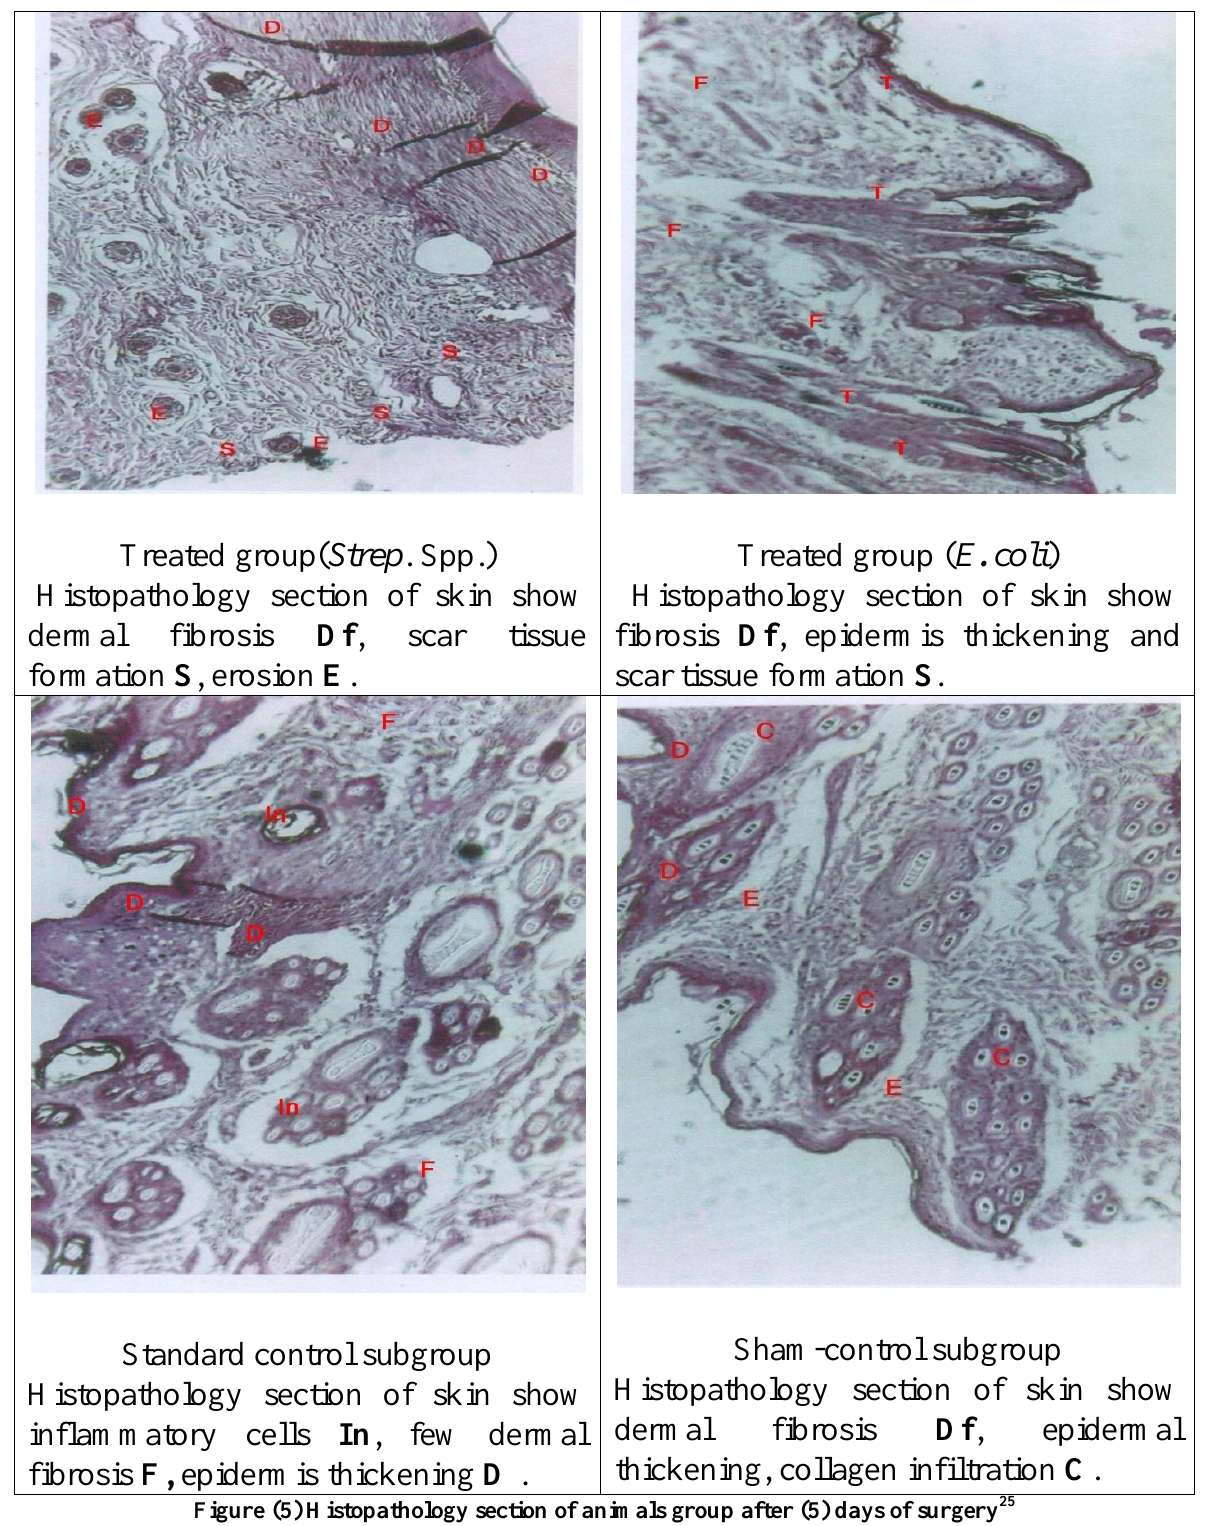
Figure (5) Histopathology section of animals group after (5) days of surgery